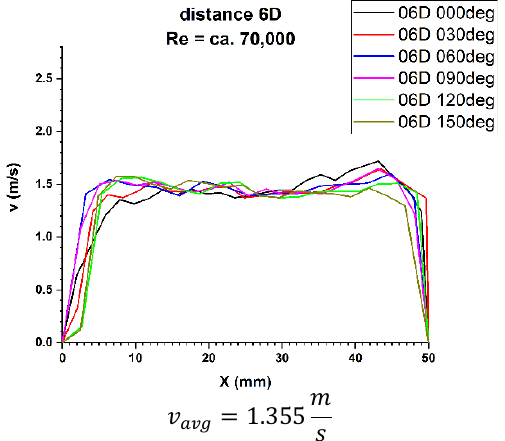
Figure 15. Velocity profiles at a distance 6D from the disturbance with marked cross-sections for Re ≅ 70,000-The LDA measurement taken in the ultrasound wave path.